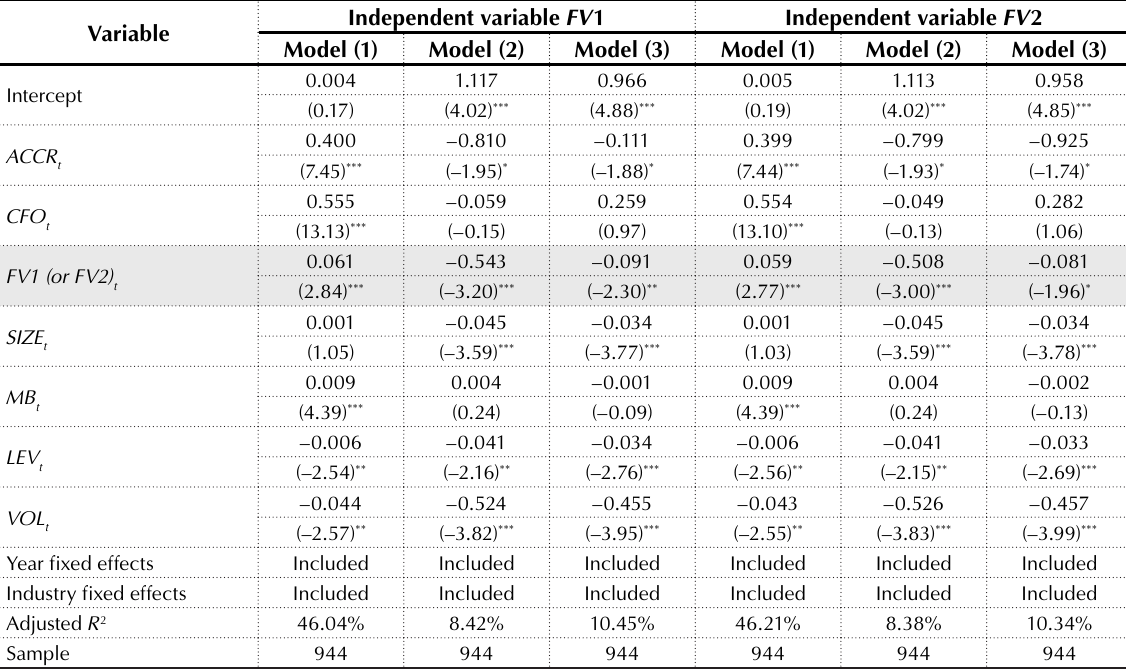
Table 4. Predictability and pricing of fair value for future